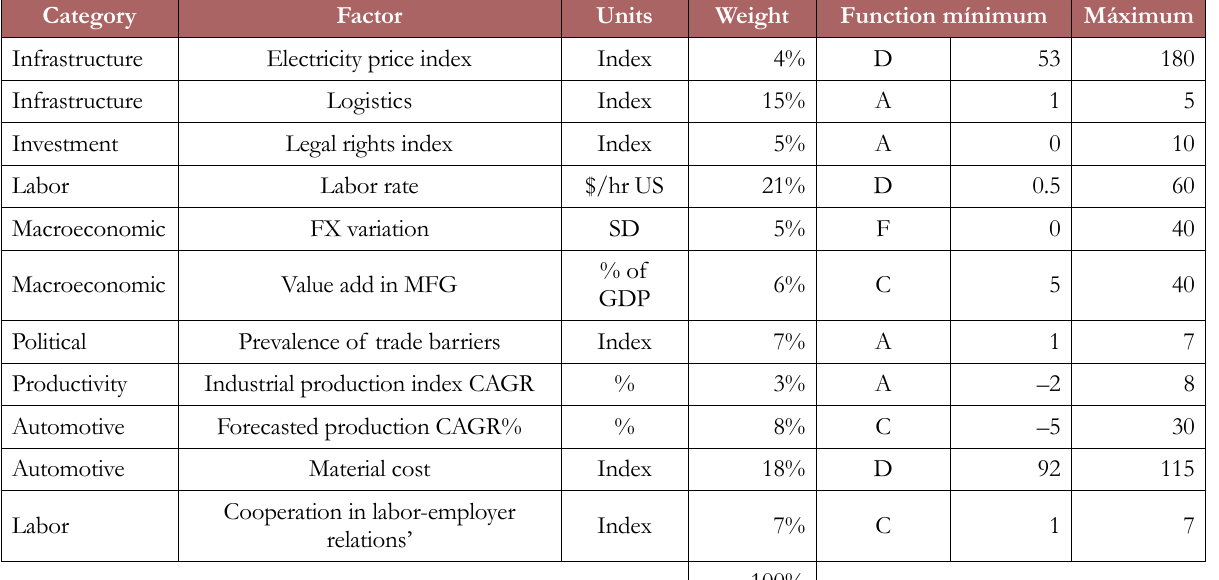
Table 4. Expanded view of final